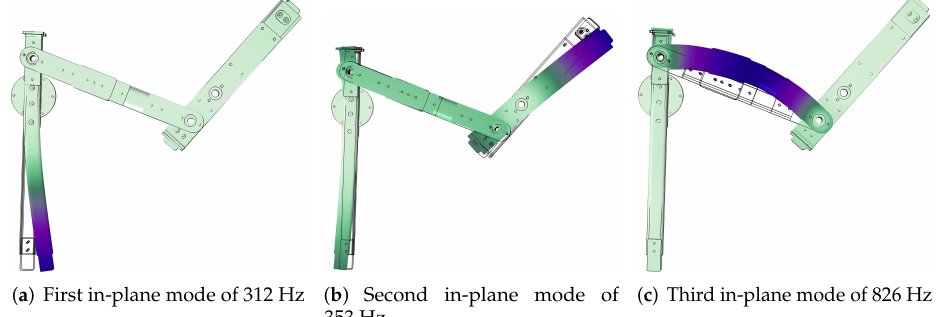
Figure 5. First three in-plane mode shapes with their natural frequency from finite element analysis at θ 1 = 88.2 deg. With dark blue the largest displacements of a specific mode shape are shown. The displacements are strongly amplified.